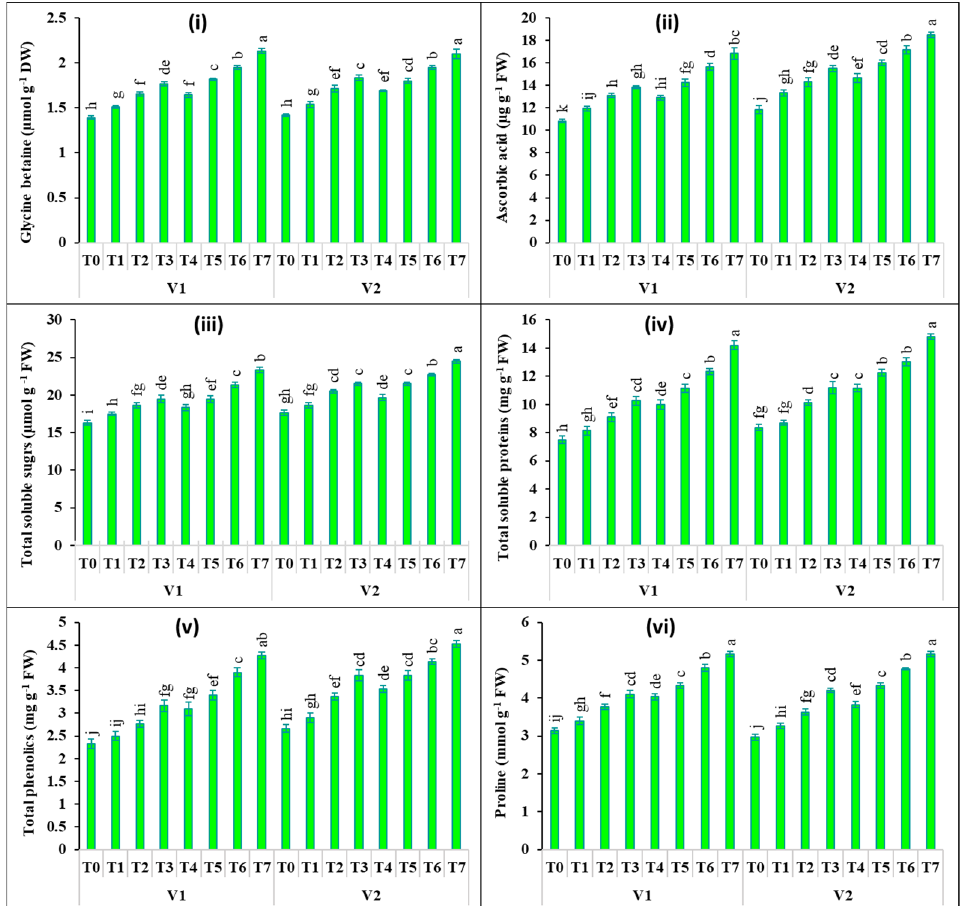
Figure 5. Influence of salicylic acid priming on ( i ) glycine betaine/GB, ( ii ) ascorbic acid/AsA, ( iii ) total soluble sugars/TSS, ( iv ) total soluble proteins/TSP, ( v ) total phenolics, and (vi) proline content under salt stress; T0 (control), T1 (hydropriming), T2 (10 mM SA priming), T3 (20 mM SA), T4 (170 mM NaCl), T5 (170 mM NaCl + hydropriming), T6 (170 mM NaCl + 10 mM SA priming), and T7 (170 mM NaCl + 20 mM SA priming); bars sharing same case letter or without lettering, for a parameter, do not significantly differ ( p ≤ 0.05) by the LSD test.